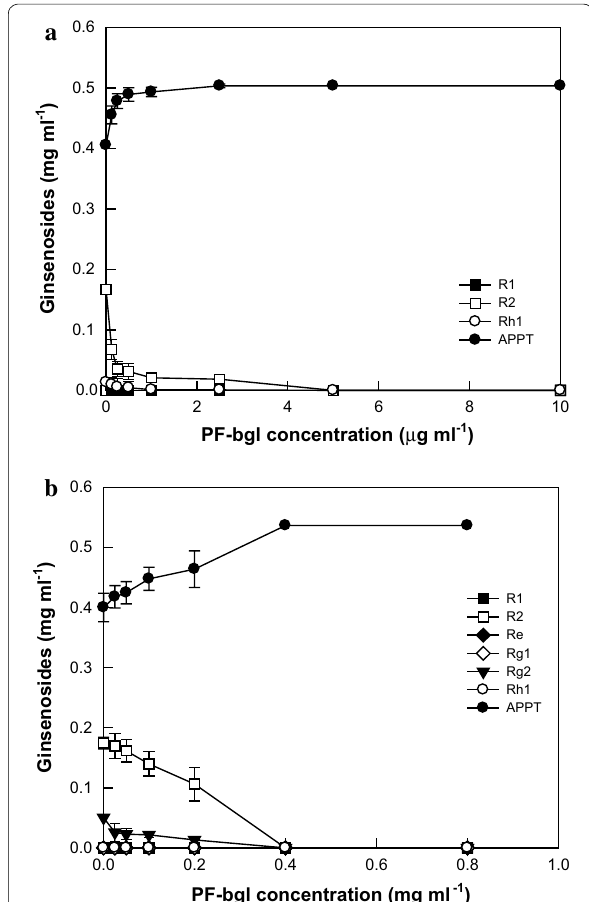
Fig. 4 Determination of the minimal concentration of PF‑bgl to DT‑bgl for the complete conversion of PPT‑type ginsenosides to APPT. a Ginsenoside R1. The reactions were performed at 80 °C in 50 mM citrate/phosphate buffer (pH 6.0) containing 1.0 mg ml − 1